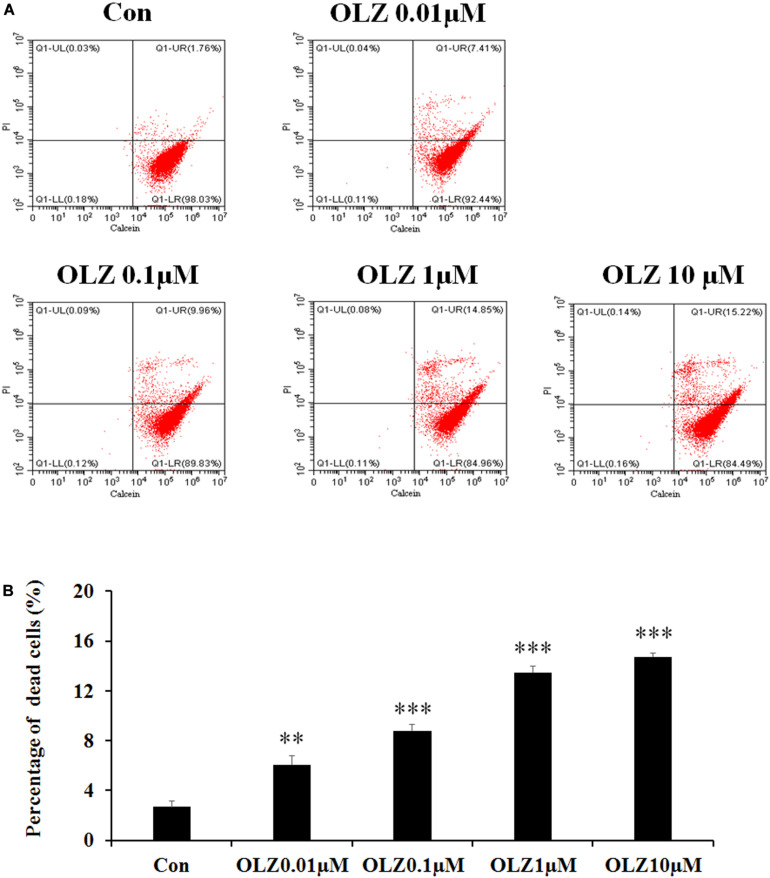
Calcein/PI flow cytometric assay of astrocytes after 72-h olanzapine treatment. (A) Representative dot-plot graphs from analysis of 0.01, 0.1, 1, and 10 μM olanzapine treatment-exposed samples, double stained with calcein and PI. (B) Statistical analysis of percentage of dead cells (%) after 0.01, 0.1, 1, and 10 μM olanzapine treatment for 72 h. Calcein indicates acetoxymethyl ester; PI, propidium iodide. All data were presented as mean ± SEM. Statistical significance was defined as p < 0.05 (∗∗p < 0.01, ∗∗∗p < 0.001 vs. control). Con, control; OLZ, olanzapine.